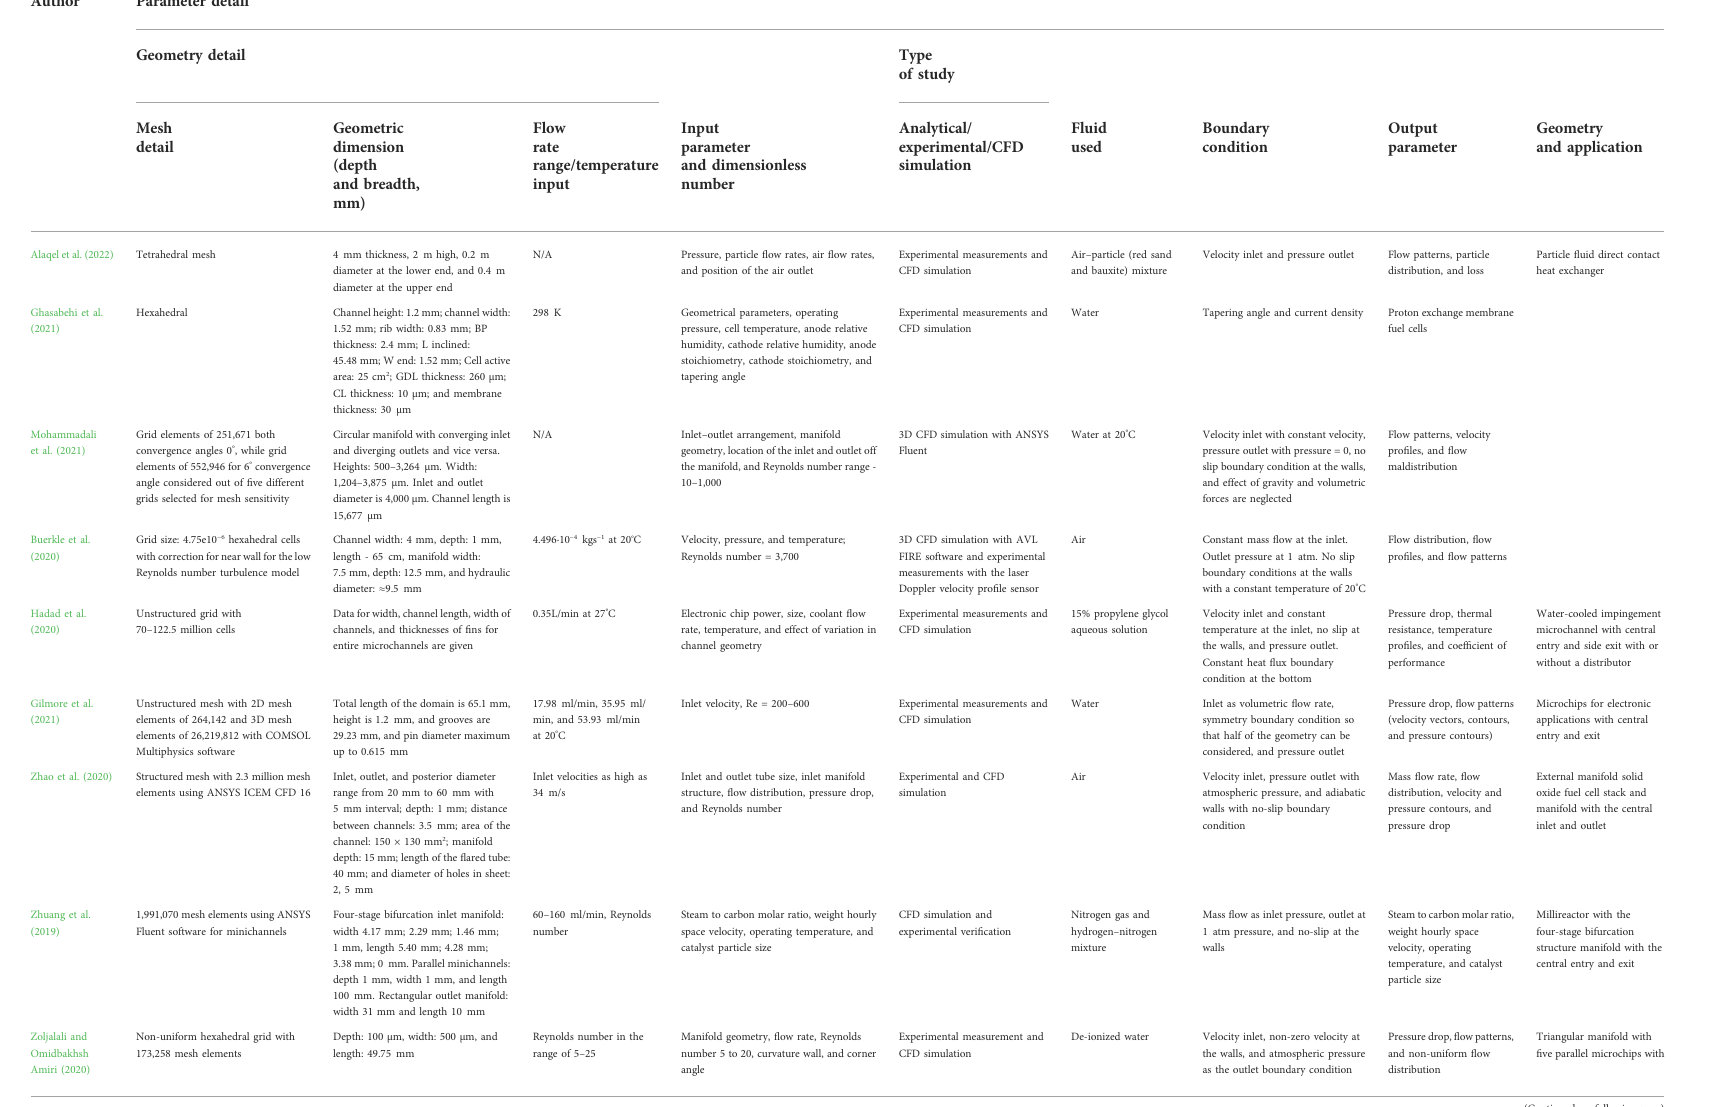
TABLE 1 Experimental and CFD details of research works available in the published